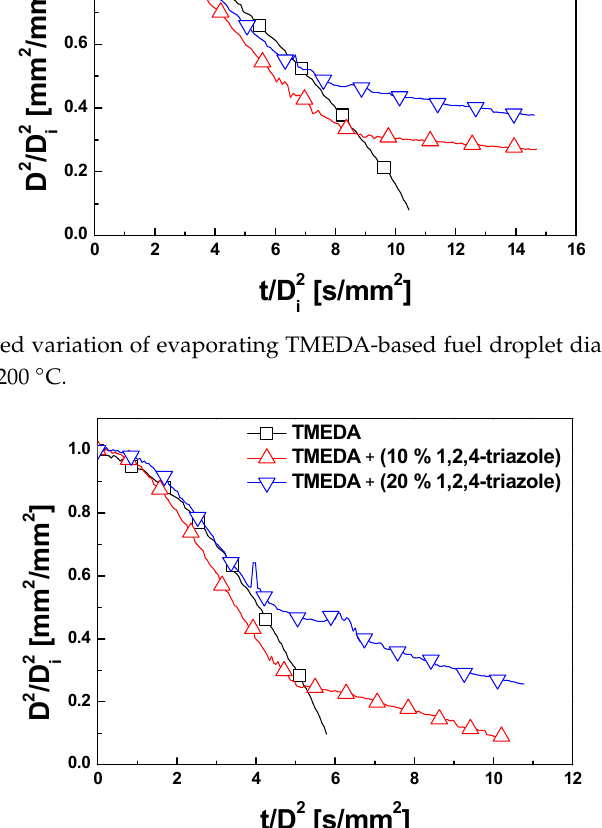
Figure 9. Normalized variation of evaporating TMEDA-based fuel droplet diameter squared with normalized time at 300 °C.